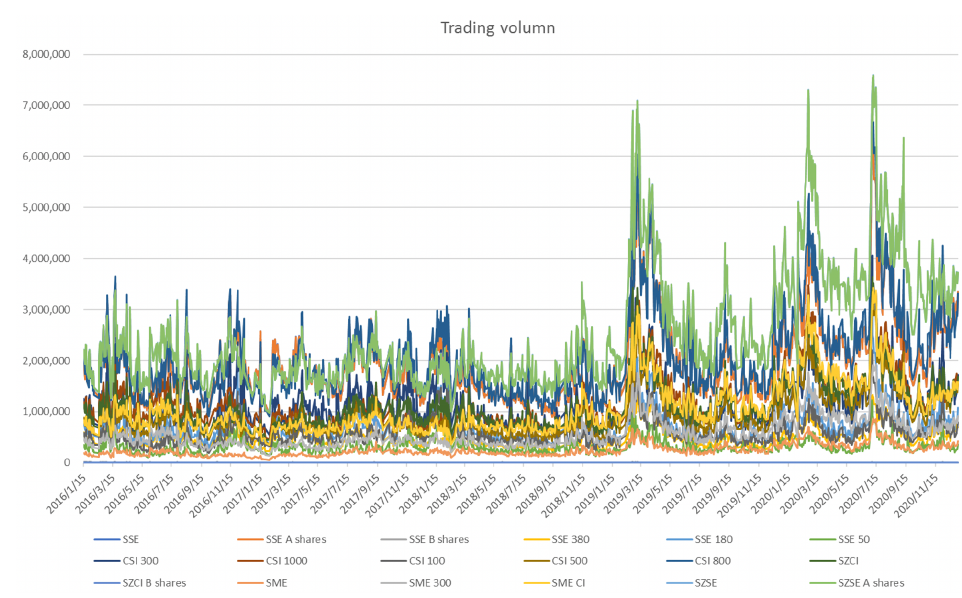
Figure A5. History of trading volume in 18 Chinese stock